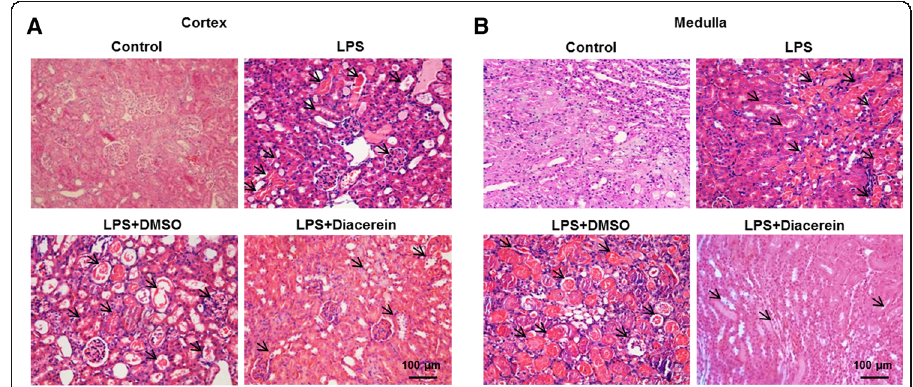
Fig. 2 Diacerein ameliorated kidney injury in endotoxemic mice. a and b Mice were injected intraperitoneally with lipopolysaccharide (LPS, 10 mg/kg) for 24 h, and then treated with diacerein (15 mg/kg/day) for a further 48 h. Histological analysis of representative renal cortex ( a ) and medulla ( b ) slides of control, LPS, LPS+DMSO and LPS+Diacerein groups. n =8 in each group (magnification, 100×). Arrows indicate pathologic changes, such as glomerular congestion and atrophy, interstitial hemorrhages, and epithelial cell necrosis and shedding